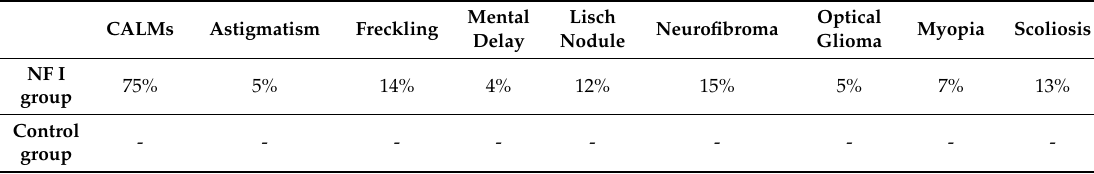
Table 2. Systemic manifestations detected in NF I and control